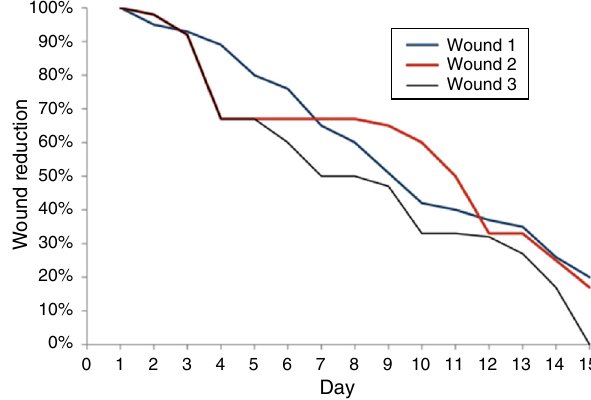
Chart comparing of the healing of wounds 1, 2, and 3 by measuring the wounds 1, 2, and 3 in percentages, throughout the 15 days of the experiment.